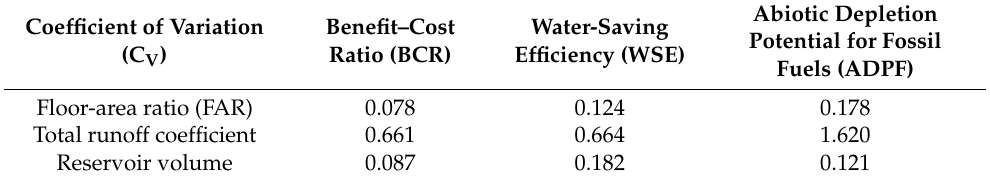
Table 7. Assessment of Monte Carlo simulation